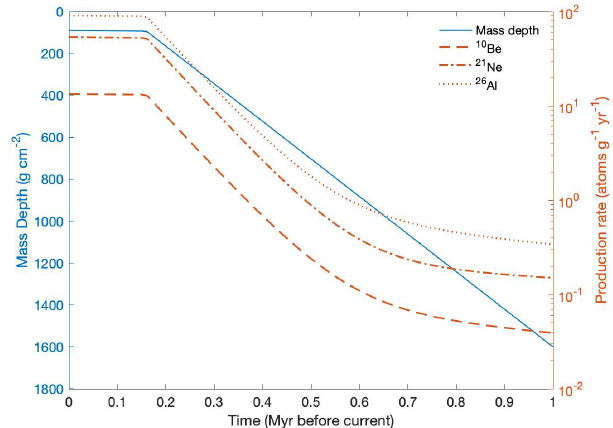
Figure 6. Graphical representation of the temporal change in mass depth (blue line) and production rates (orange lines) since ice em- placement for a sample found today at 90gcm − 2 ( ∼ 50cm below the surface) in the supraglacial debris. Here, the given sample has an initial shielding mass of 1600gcm − 2 ( ∼ 14m) and approaches the surface at the combined rate of sublimation and erosion (Eq. 11). Once the sample reaches the ice surface it becomes part of the supraglacial debris ( ∼ 0.2Ma) and approaches the surface solely at the rate of surface erosion (Eq. 10). As the sample’s mass depth de- creases, it experiences considerable changes in production rates of cosmogenic nuclides (Eq. 13). The arbitrary model parameter val- ues for these calculations are 1Ma ice emplacement, 20mMyr − 1 sublimation rate, and 0.1mMyr − 1 erosion